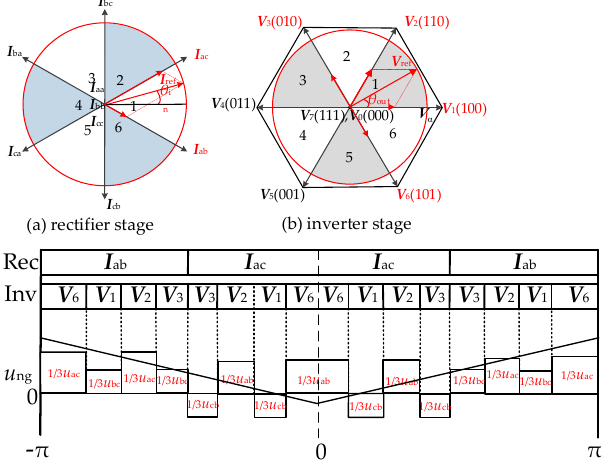
Figure 5. Modulation principle and vector distribution of method 1.